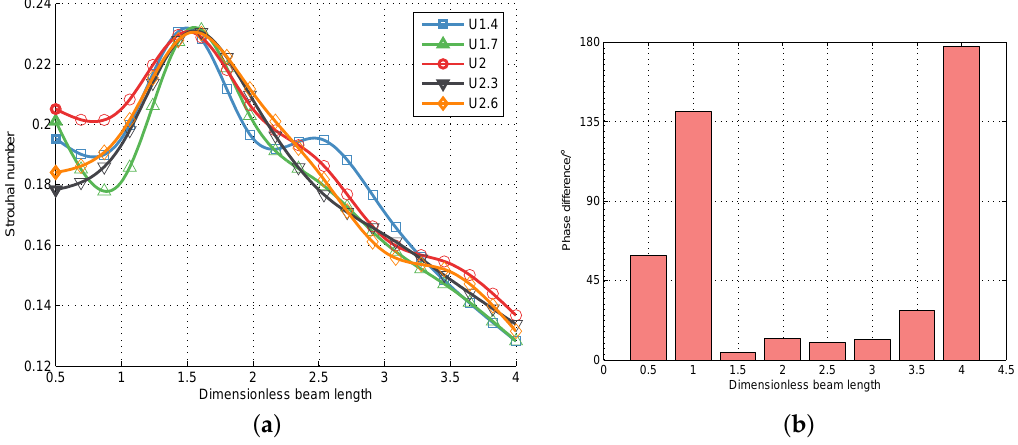
Figure 9. Variation of ( a ) Strouhal number St ; ( b ) phase difference between lift coefficients on the upper and lower surfaces of the plate versus the dimensionless plate length at different velocities.